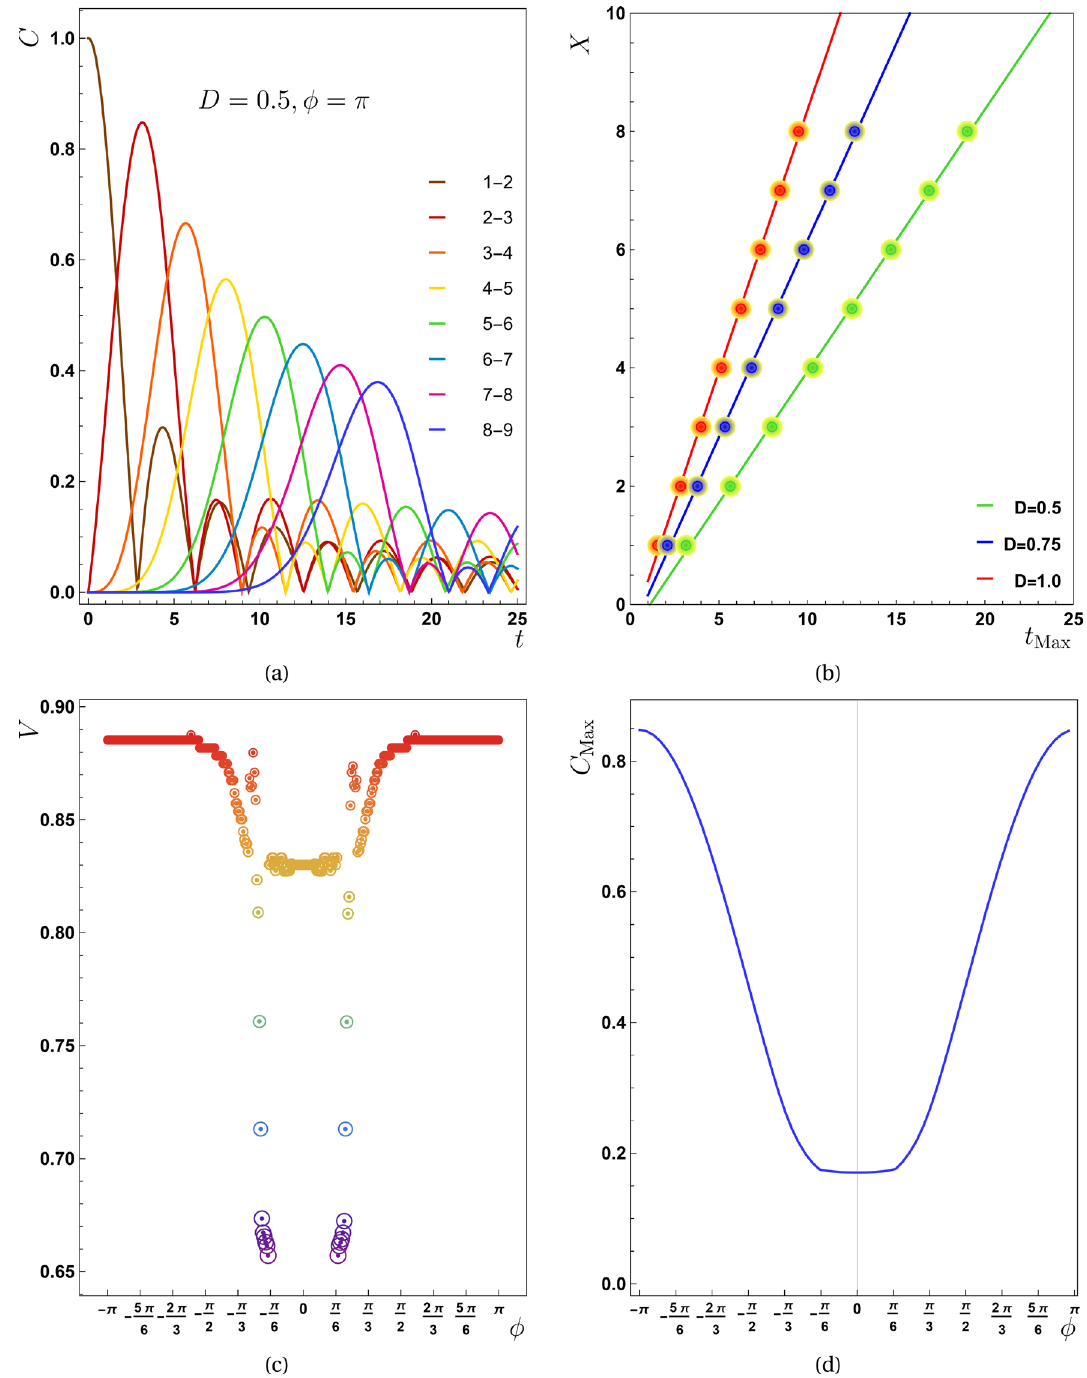
0.5 is 0, D 0 ) ( a ) the concurrence as a function of time t for D Figure 3. In the second scenario ( J = = �= t Max for different values of D is shown in this panel from which, the value presented. ( b ) The diagram of X − 0.5 , D 0.75 and D 1.0 is obtained as 0.4435 0.0005 , 0.6664 0.0005 and of propagation speed for D = = = ± ± 0.8854 0.0005 respectively. ( c ) The propagation speed with respect to the phase factor ( φ ) is represented here ± 1 . The drops that experienced by this quantity is around π/ 2 which differs from previous case (the for D = first scenario). ( d ) The maximum value of the concurrence function for the pair (2, 3) versus φ . By comparison between panels ( c ) and ( d ) we can see that the lowest value of entanglement is responsible for an interval of phase, for which the speed reaches its lowest